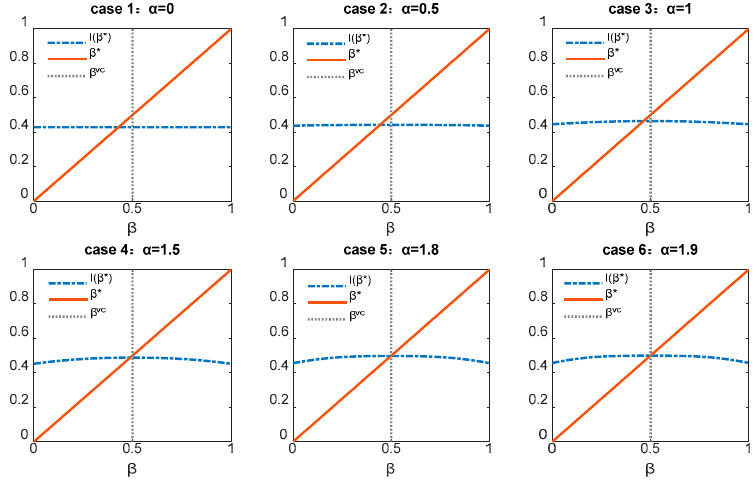
Figure 3. Optimal pay-performance sensitivity level for a different degree of complementarity α .